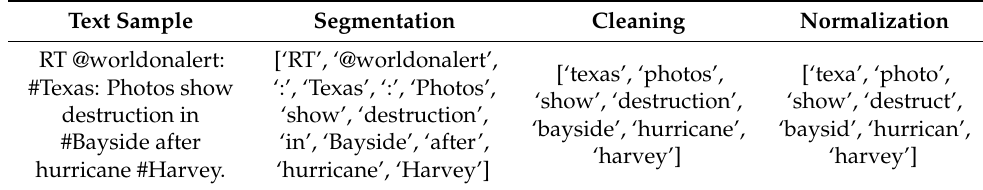
Table 7. A sample of text